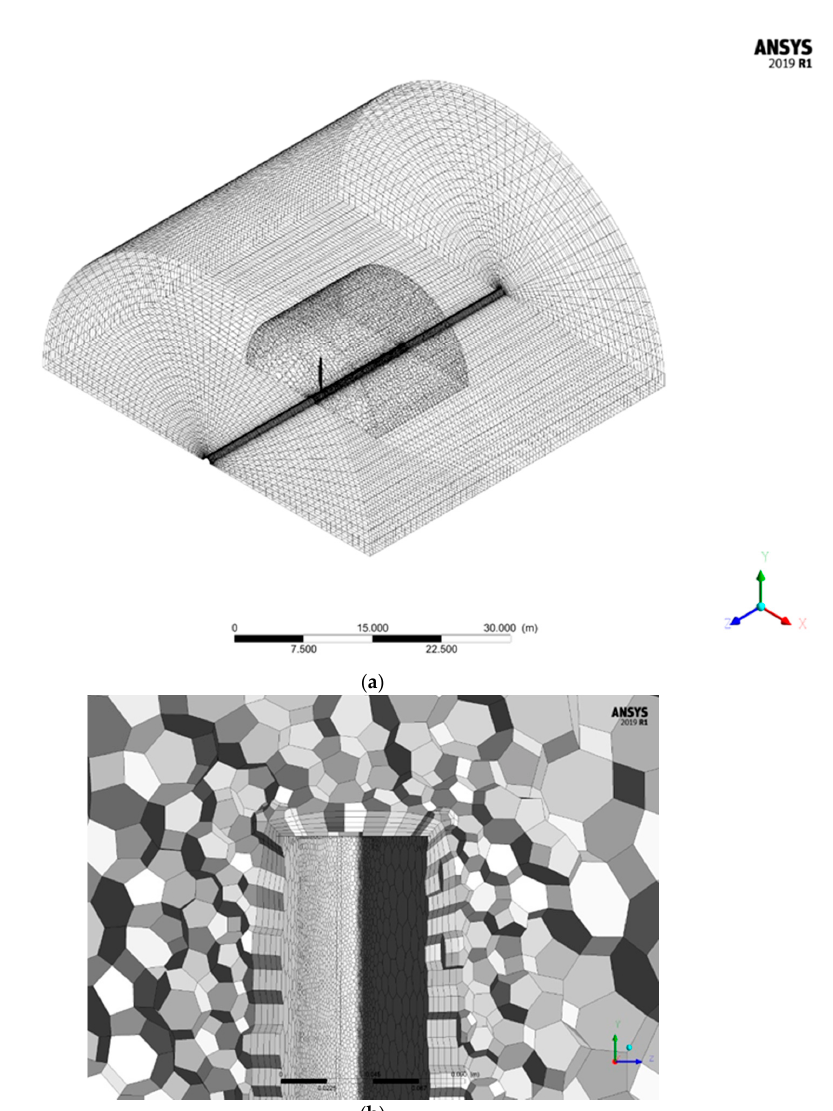
Figure 4. Mesh generated for the computational domain. ( a ) The entire domain and ( b ) a close up of the mesh near the blade tip after converting to polyhedra on Ansys Fluent (ANSYS Inc., Canonsburg, USA).